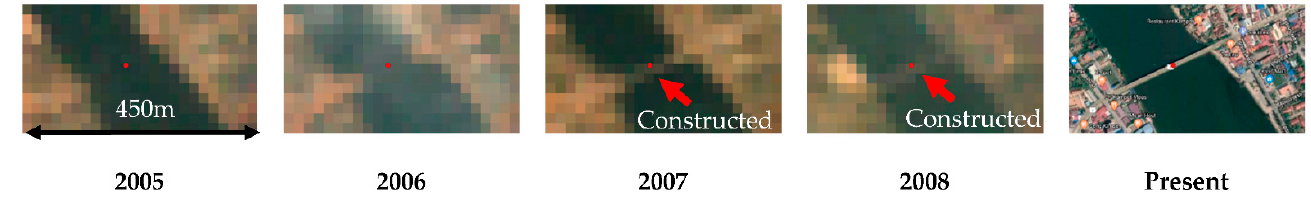
Figure 15. Satellite images of Kom Pong Bay bridge from which it can be clearly observed that the bridge was constructed in 2007.